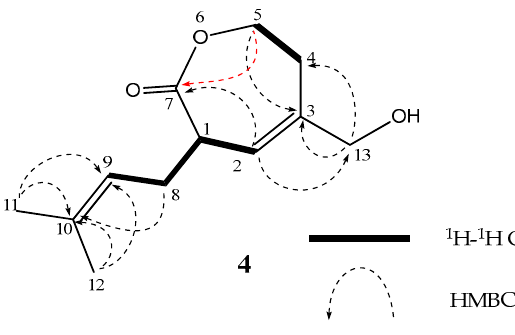
Figure 4. Selected 1 H– 1 H COSY and HMBC correlations of 4 .